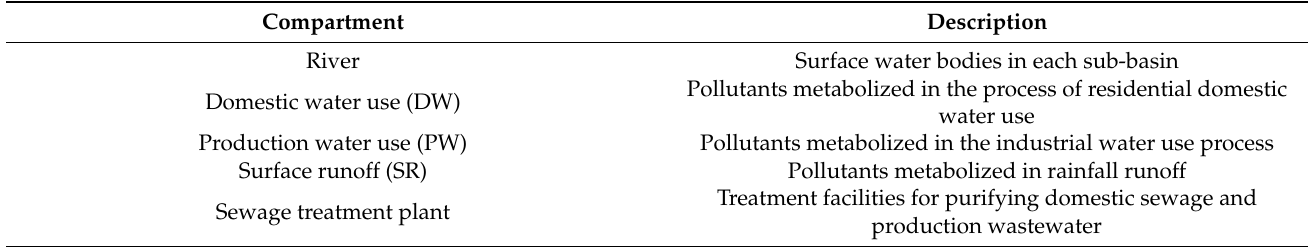
Figure 3. Water pollutant metabolism network model for the six sub-basins in Fuzhou. Table 4. Description of water pollutant metabolism network compartments for the study area.